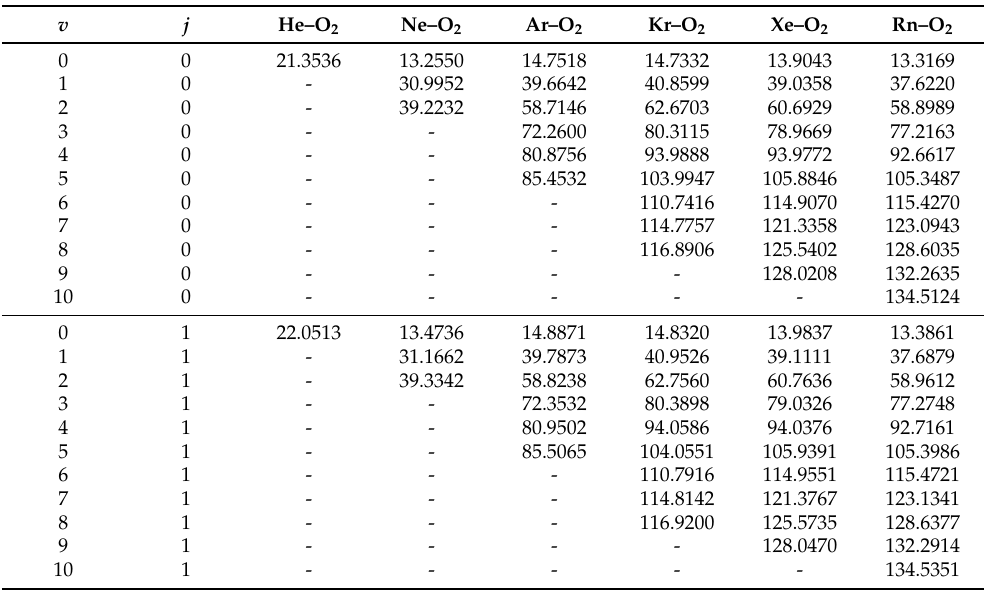
Figure 3. Improved Lennard Jones potential energy curves for the Ng–O 2 compounds obtained through the ECF approach. Table 2. Vibrational ( j = 0) and rovibrationl ( j = 1) energies in cm − 1 for the Ng–O 2 complexes obtained through CCSD(T)/aug-cc-pVTZ potential energy